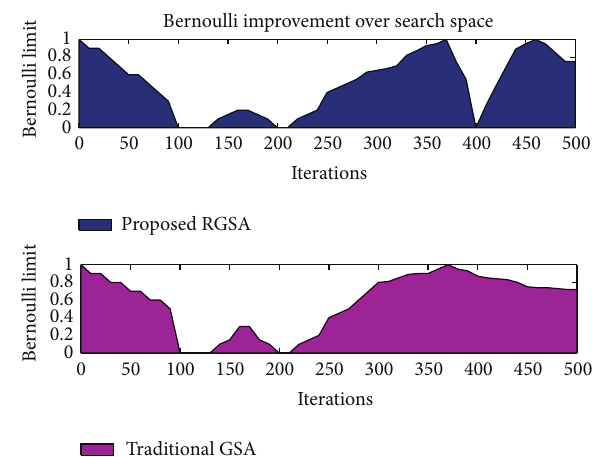
Figure 15: Feature selection improvement of proposed RGSA and traditional